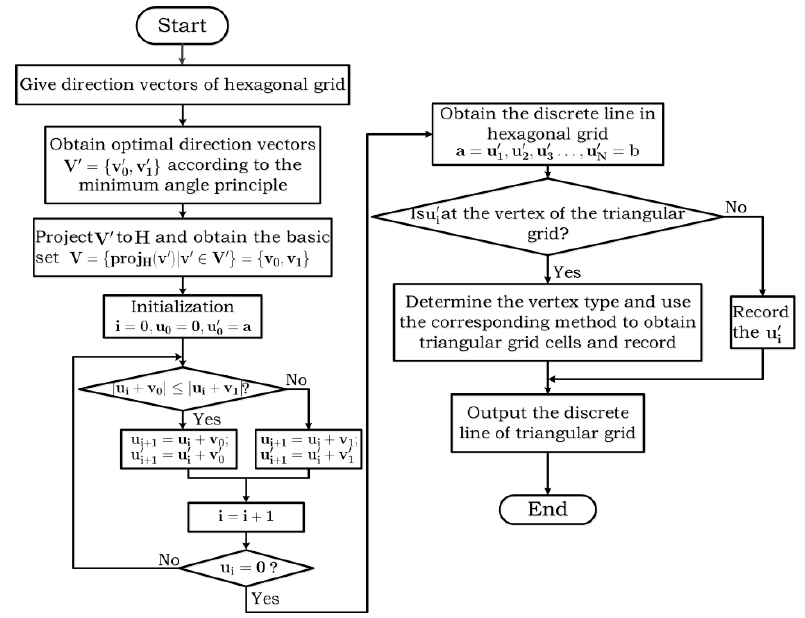
Figure 9. Flowchart of the duality and dimensionality reduction algorithm.